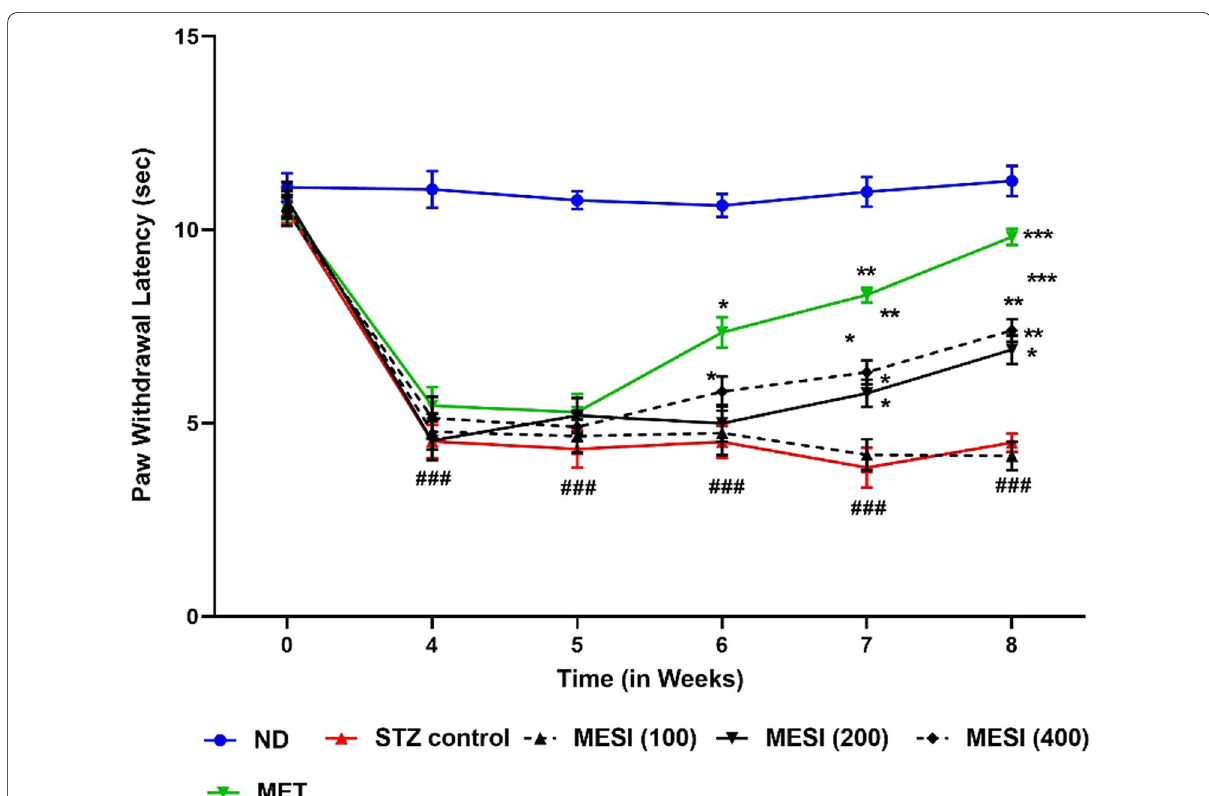
Fig. 3 Effect of chronic treatment of MESI and metformin on diabetes-induced thermal hyperalgesia in Eddy’s hot plate test. Data are expressed as mean SEM ( n 6) and analyzed by two-way ANOVA followed by Bonferroni’s multiple range post hoc test. * P < 0.05 and ** P < 0.01 for MESI, and ± = *** P < 0.001 for metformin-treated groups compared to the diabetic (STZ) control group. ### P < 0.001 for the diabetic (STZ) control group compared to the normal non-diabetic